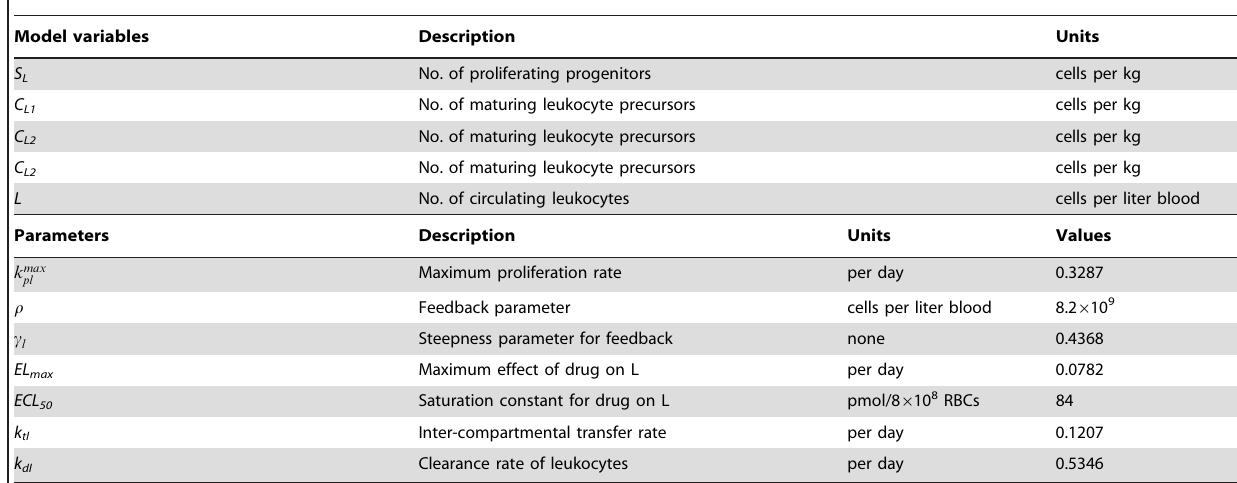
Table 2. Glossary of state variables and parameters for leukopoiesis model.